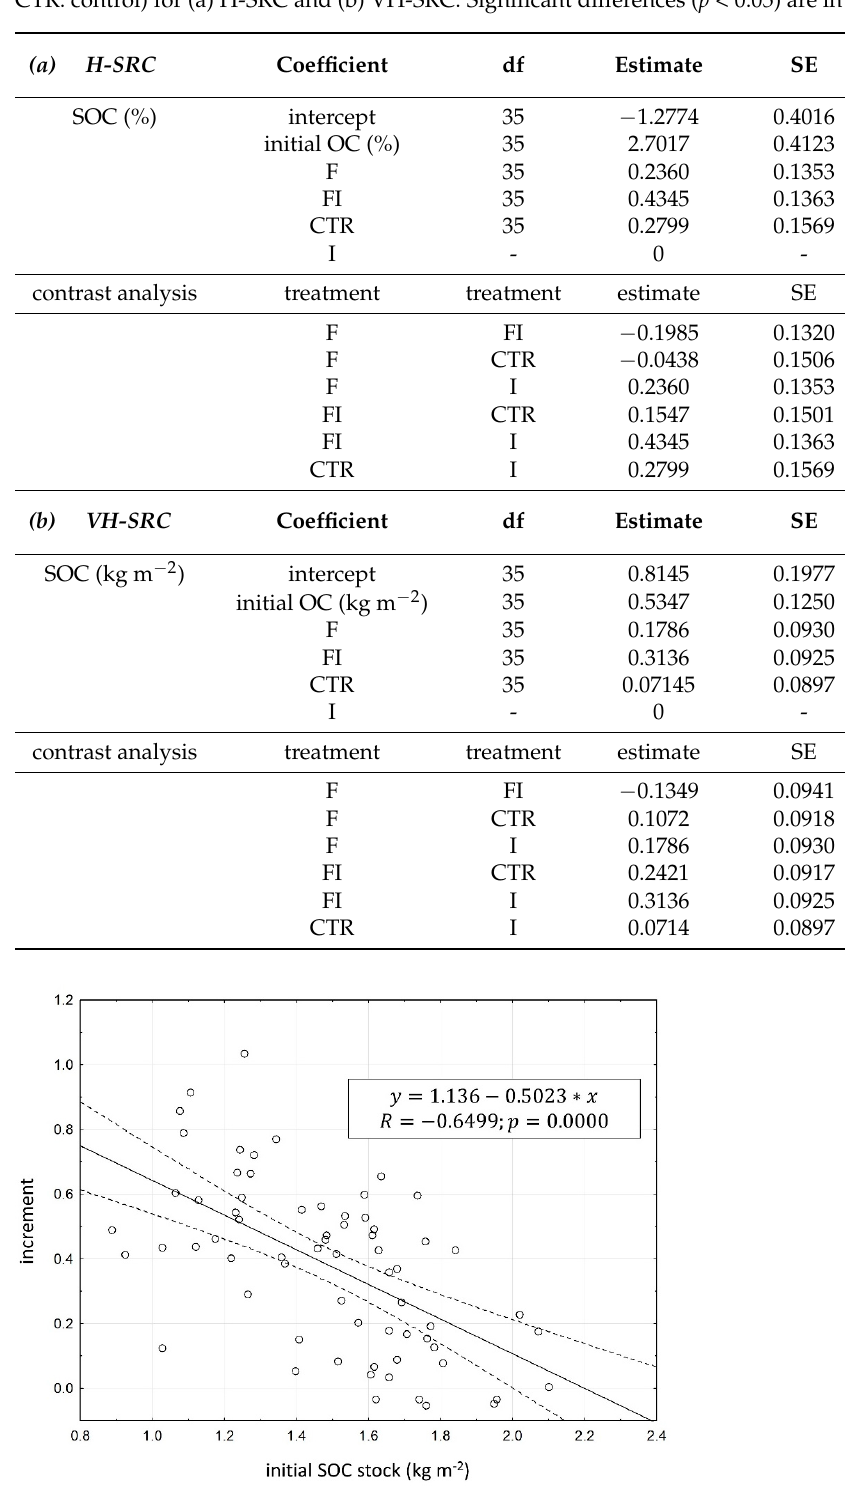
Figure 3. Map of 6-year increments of SOC stock (kg m − 2 ) distinguishing treatments in H-SRC (on the right) and VH-SRC (on the left). The overlapping white grid represents the agronomic treatment model. FI: fertilization and irrigation; I: irri- gation; F: fertilization; CTR: control.